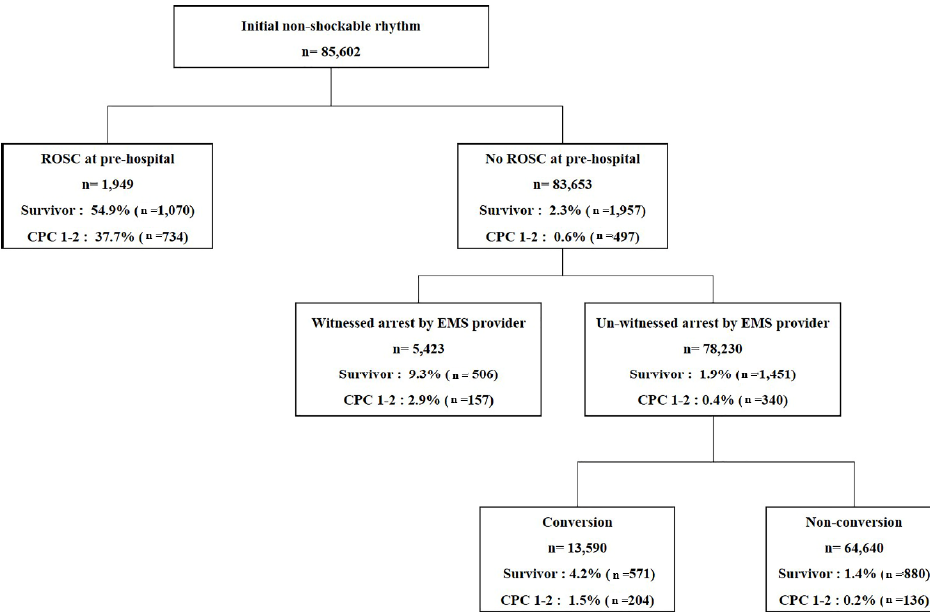
Figure 2. Outcomes according to pre-hospital ROSC and the state of being witnessed by an EMS provider. EMS, emergency medical services; CPC, cerebral performance category. In patients without pre-hospital ROSC and un-witnessed by an EMS provider, the rates of survival to discharge in the conversion and non-conversion groups were 4.2% and 1.4%, respectively ( p < 0.001) and the rates of good neurologic outcome at hospital discharge were 1.5% and 0.2%, respectively ( p < 0.001) (Figure 2).